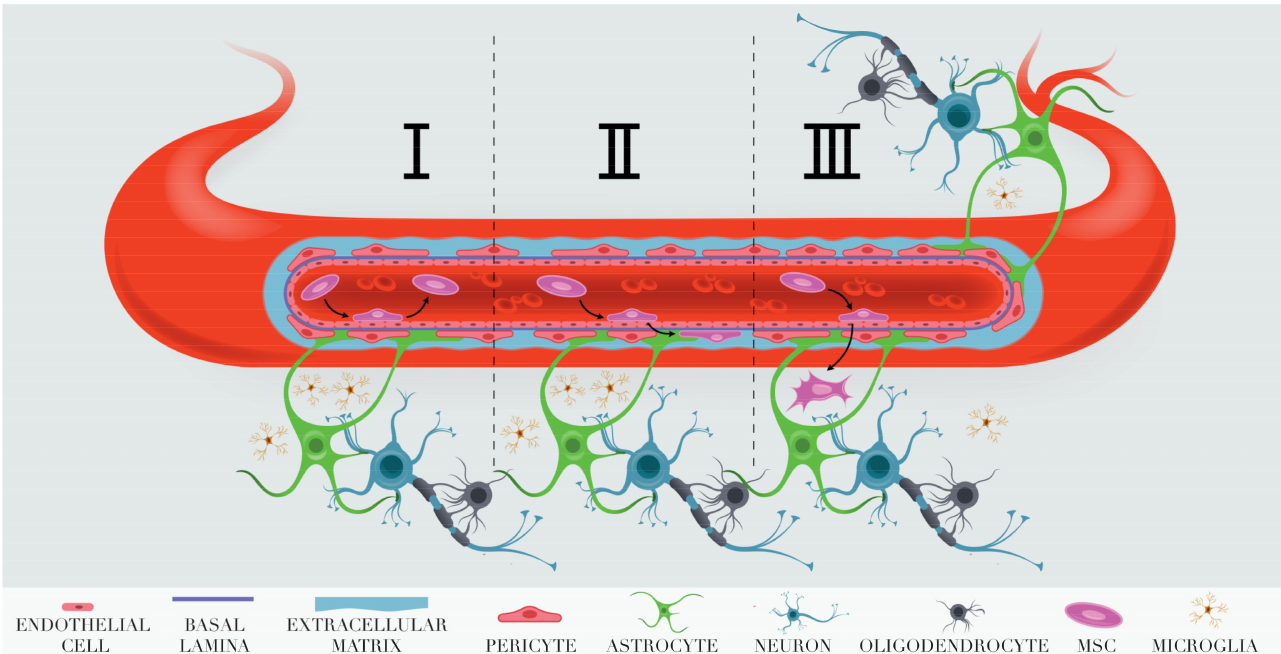
Figure 1. Schematic representation of the possible outcomes for MSCs adhering to the brain blood vessel endothelium after IA transplantation into rats with experimental stroke. I. Return to circulation. II. Infiltration into the perivascular space. III. Invasion into brain